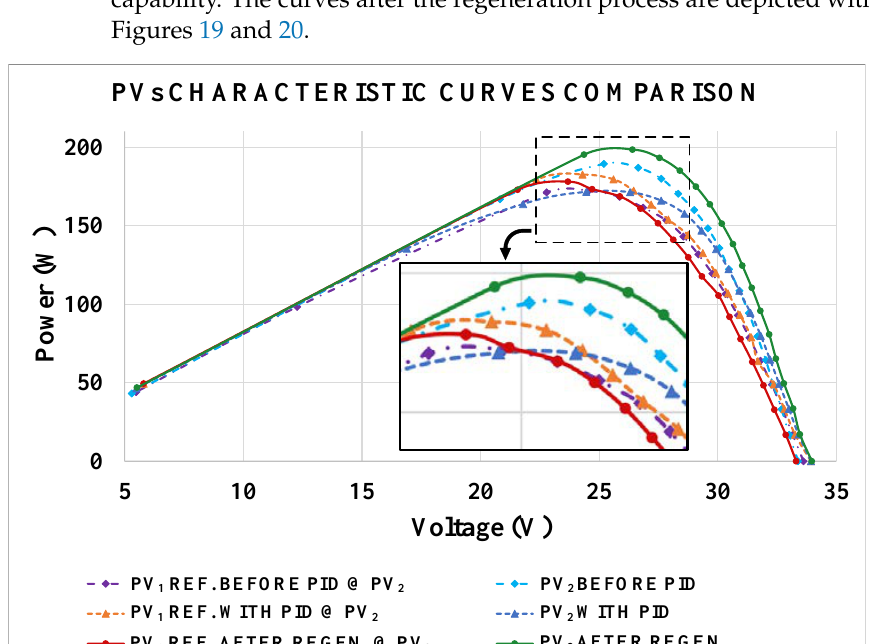
Figure 19. Comparison between the measured P-V characteristic curves of the PV 1 (purple) and PV 2 (cyan) panels before PID (dot-dashed); PV 1 (orange) and PV 2 (blue) panels with enforced PID (dashed); and PV 1 (red) and PV 2 (green) panels after regeneration of the PV 2 (continuous).